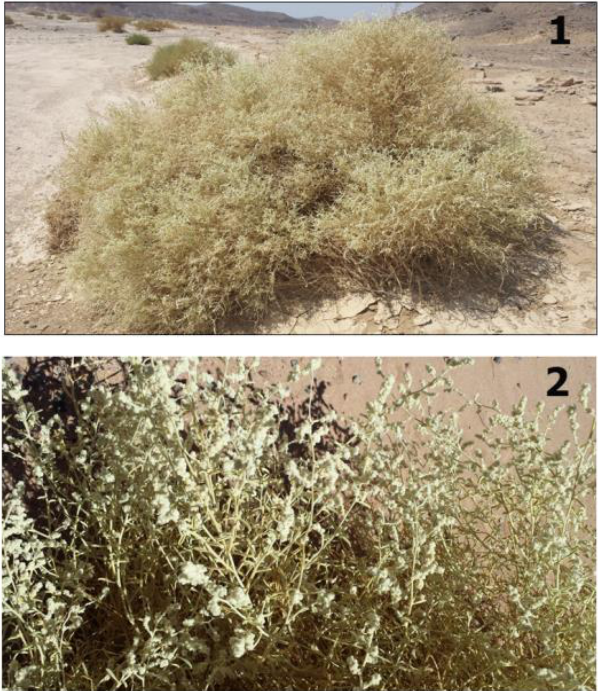
Figure 2. Photograph of Aerva javanica plant collected from Ras Garib (1) and Qeft-Qusseir Road (2).